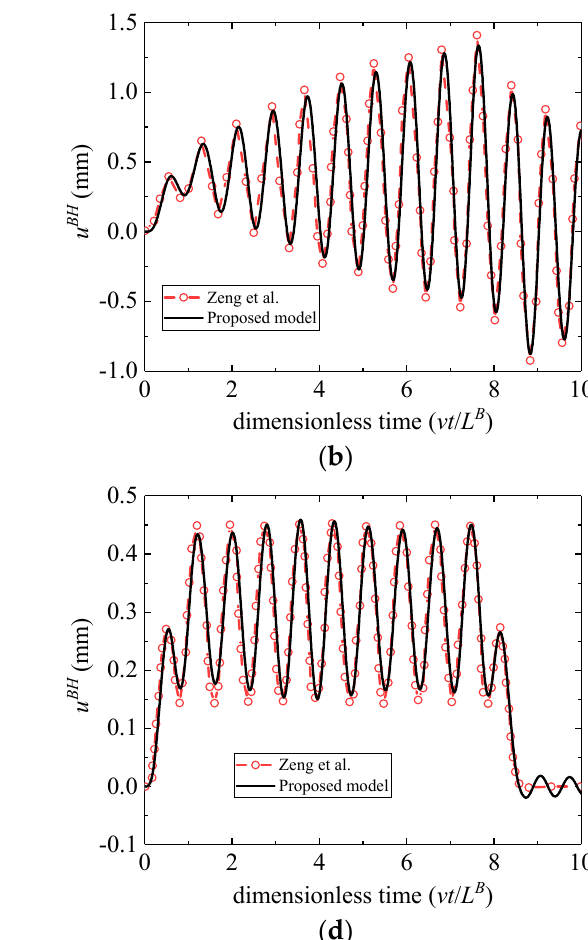
Figure 4. Validation of bridge dynamic time history response: ( a ) Vertical displacement: 314 km/h; ( b ) Radial displacement: 458 km/h; ( c ) Vertical displacement: 268 km/h; ( d ) Radial displacement: 391 km/h.